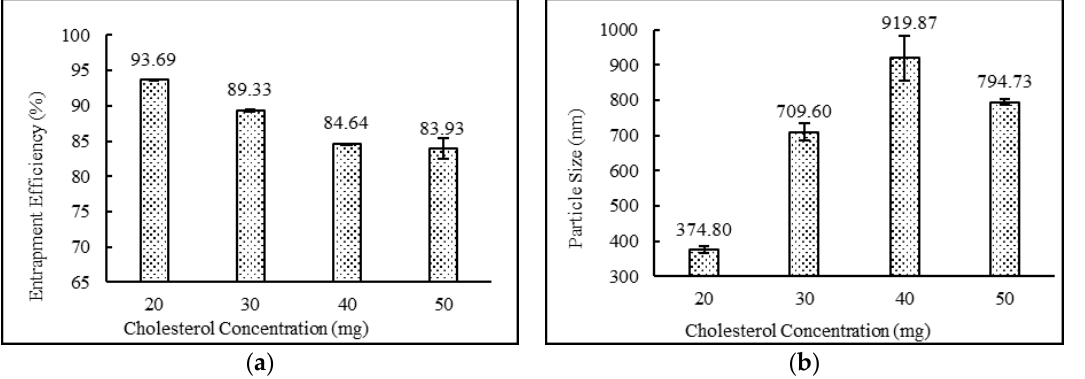
Figure 3. Effect of cholesterol concentration (mg) on ( a ) entrapment efficiency (%) and ( b ) particle size (nm) of niosomes. ( N = 3, mean ± SD)